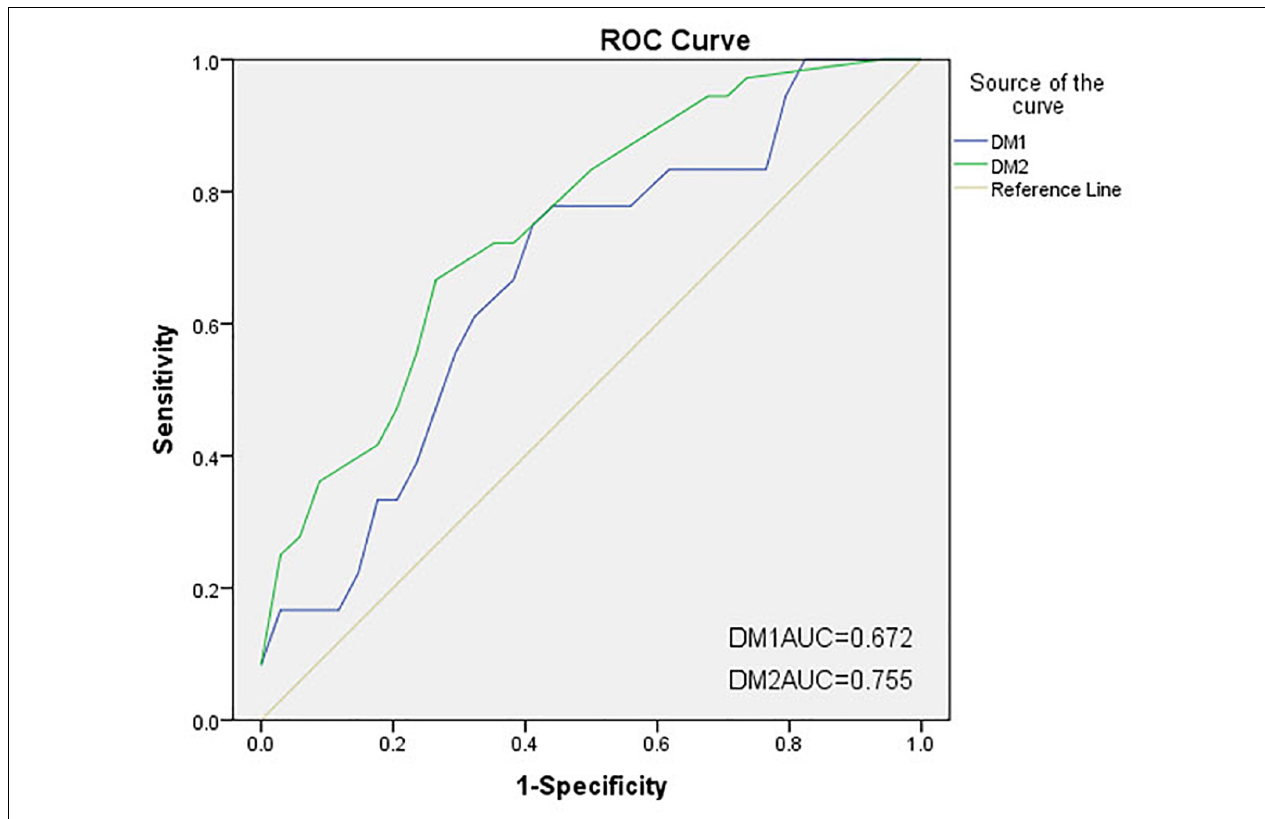
FIGURE 2 | Receiver operating characteristic (ROC) curves of two discriminant models for freezing of gait (FOG). The areas under the ROC curves (AUCs) for DM1 and DM2 were 0.672 and 0.755, respectively. DM1, discriminant model 1 (traditional walking tests); DM2, discriminant model 2 (C-Gait